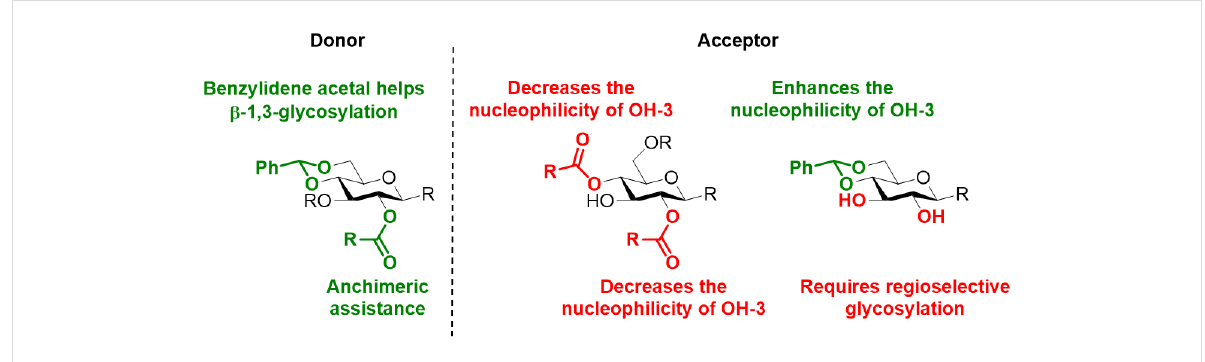
Figure 4: Synthetic strategies and issues associated to the formation of the β (1–3)